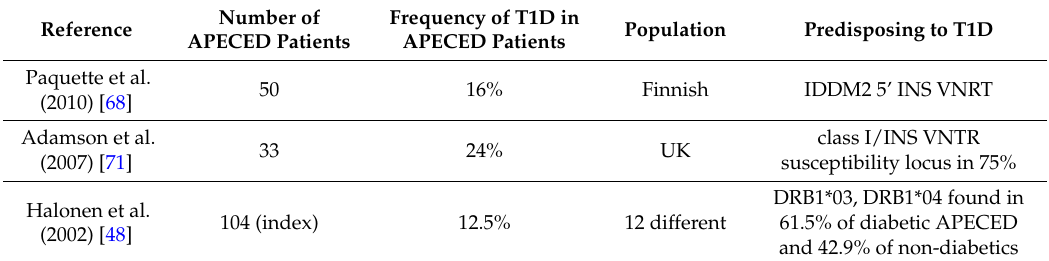
Table 2. Main studies referring to genes conferring genetic susceptibility to T1D in APECED patients. Number of Frequency of T1D in Population Predisposing to T1D Reference APECED Patients APECED Patients Paquette et al. (2010) [68]